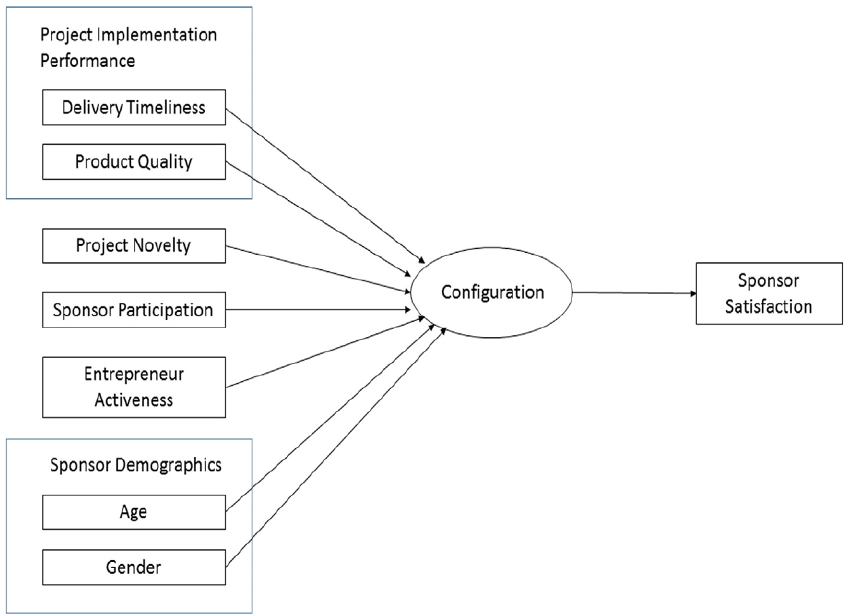
Figure 7. Conceptual model of factors influencing the satisfaction of sponsors